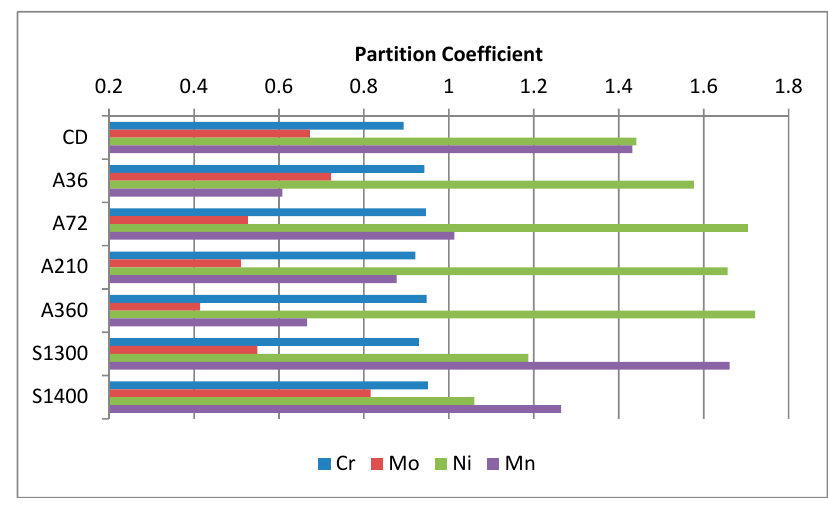
Figure 6. Alloying element partitioning between the austenite and ferrite as stated in Equation (4).